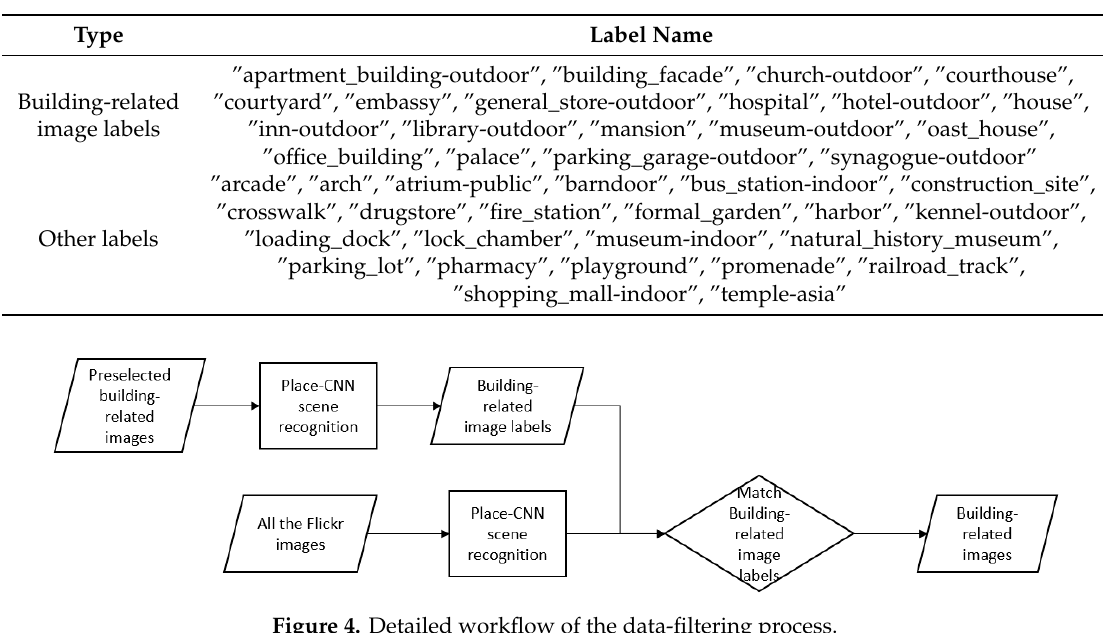
Table 1. Building-related image labels and other labels.